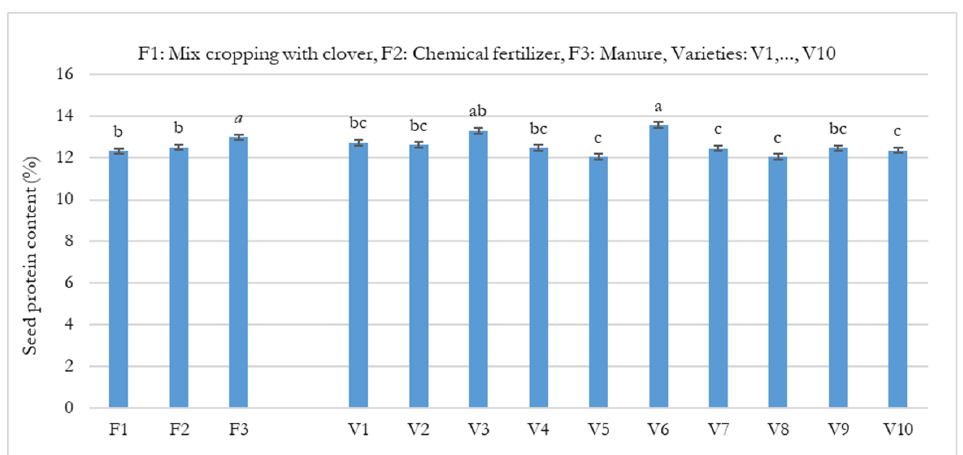
Figure 1. Effect of fertilization and variety on wheat seed protein content Means followed by the same letter shows no significant differences among treatments at 0.05 level by LSD V1= ‘Mazar-99’, V2= ‘Baghlan-09’, V3= ‘Chont-1’, V4= ‘Kabul-13’, V5= ‘Gul-96’, V6= ‘Mugawim’, V7= ‘Shoshom-